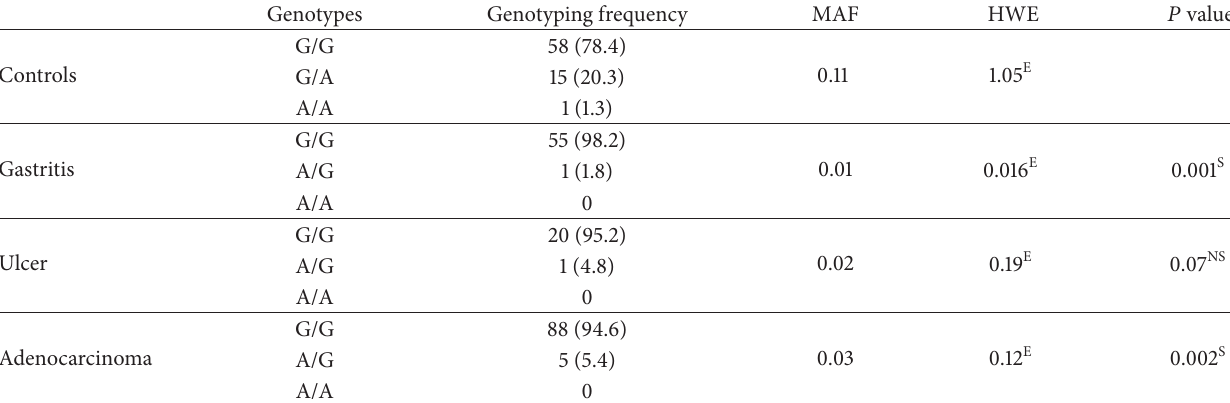
Table 3: Genotype frequencies of TNF- 𝛼 − 238 (G/A) among cases and controls and the association with gastric pathology.